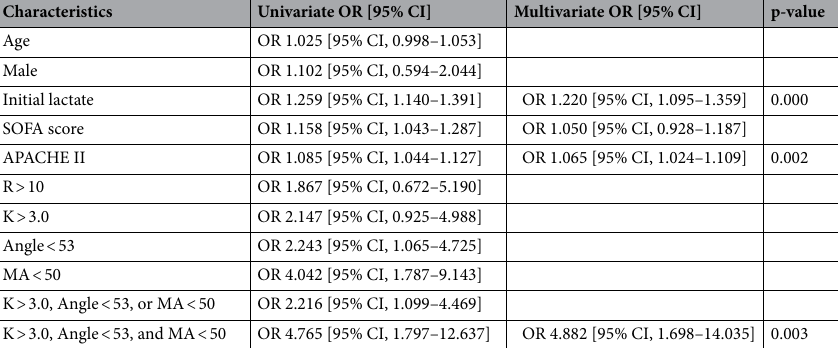
Table 4. Univariate and multivariate analysis for predicting the outcomes in septic shock patients. Multivariate analysis included logistic regression analysis and backward elimination. OR odds ratio; CI confidential interval; SOFA Sequential Organ Failure Assessment; APACHE Acute Physiology and Chronic Health